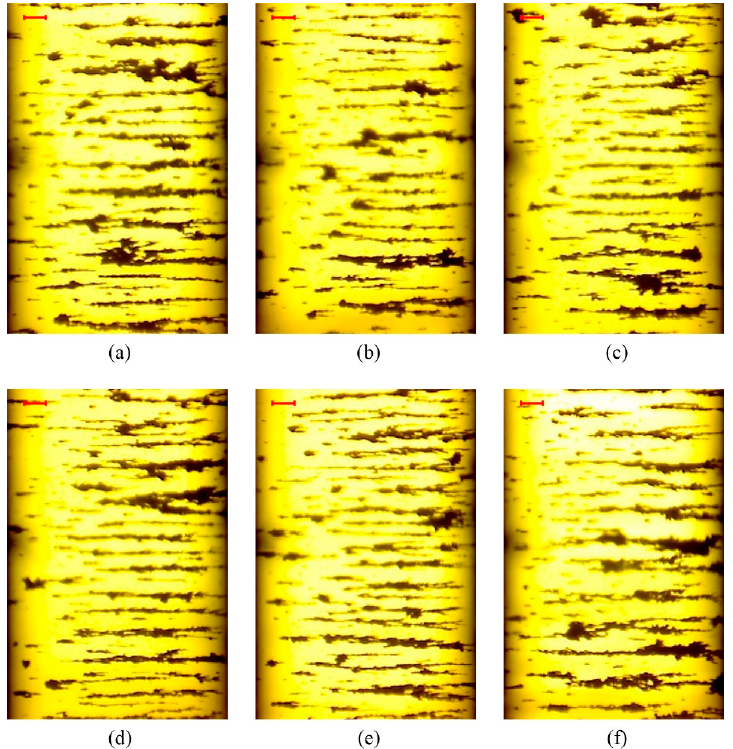
Figure 10. Representative ferrograms with interference shadows (the bar is 100 μ m): ( a ) 22 min; ( b ) 2